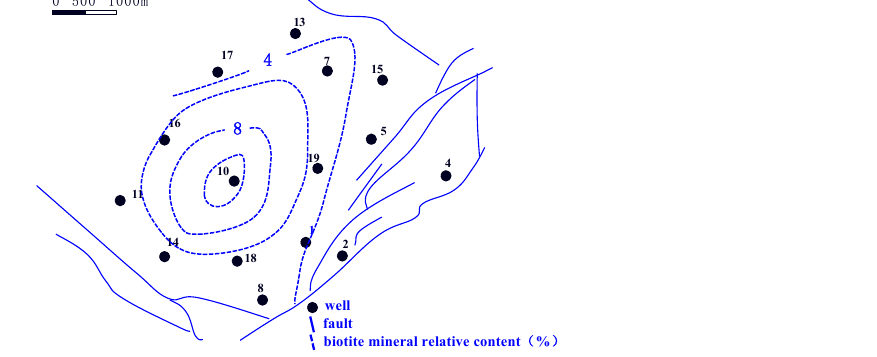
Figure 8. Planar distribution map of relative biotite mineral content in buried-hill.